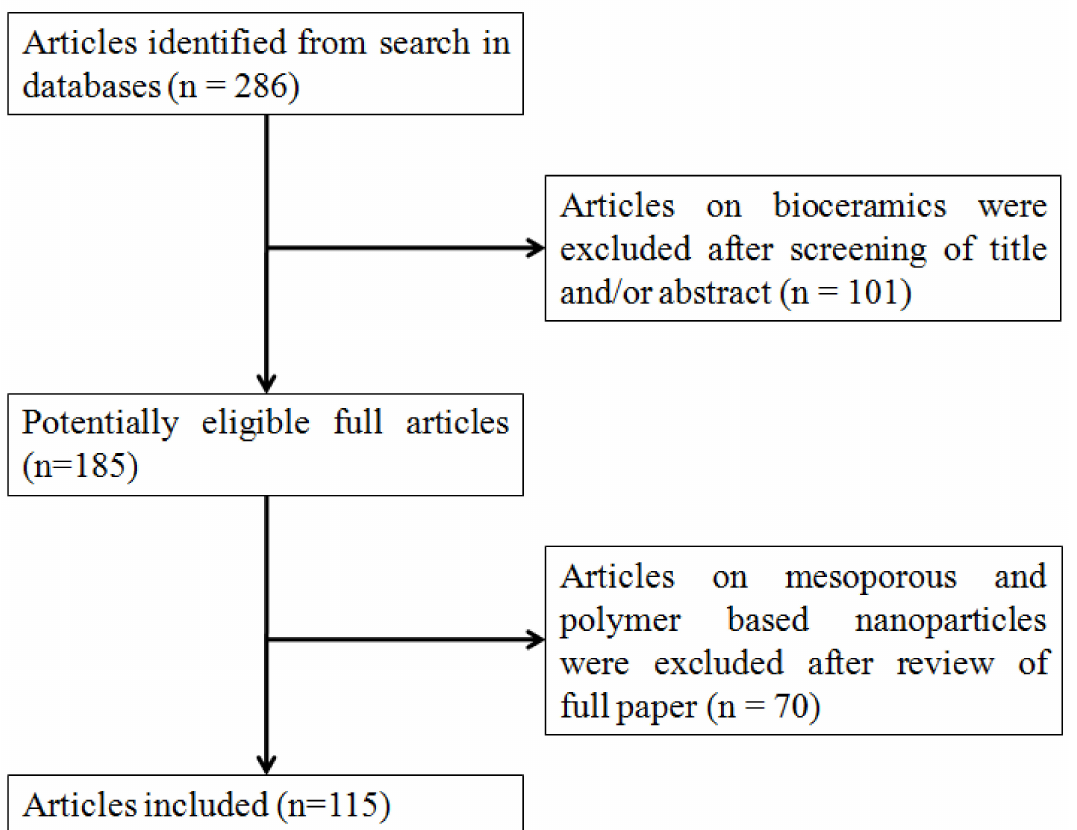
Scheme 1. Process for article selection based on the inclusion